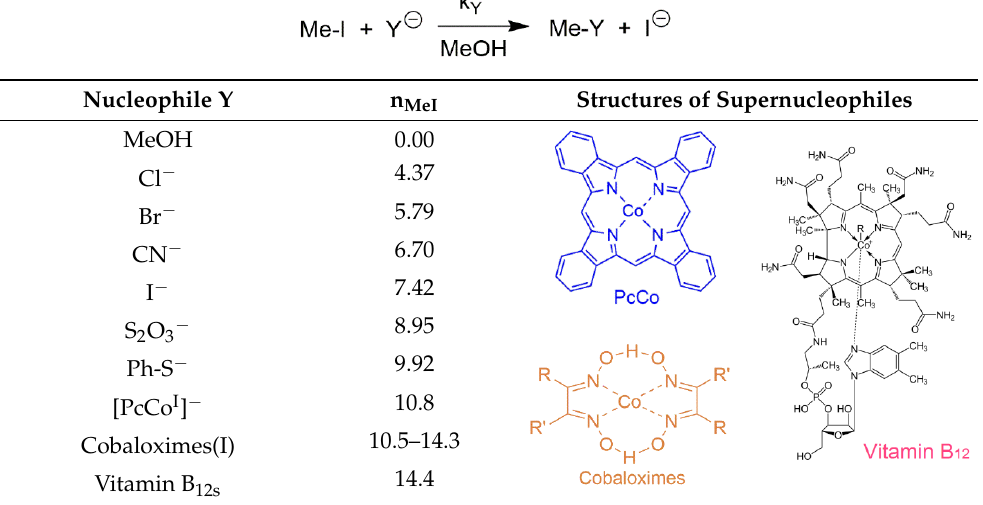
Table 1. Relative nucleophilicity n MeI = log (k Y /k MeOH ) for the following reaction at 25 °C [5].